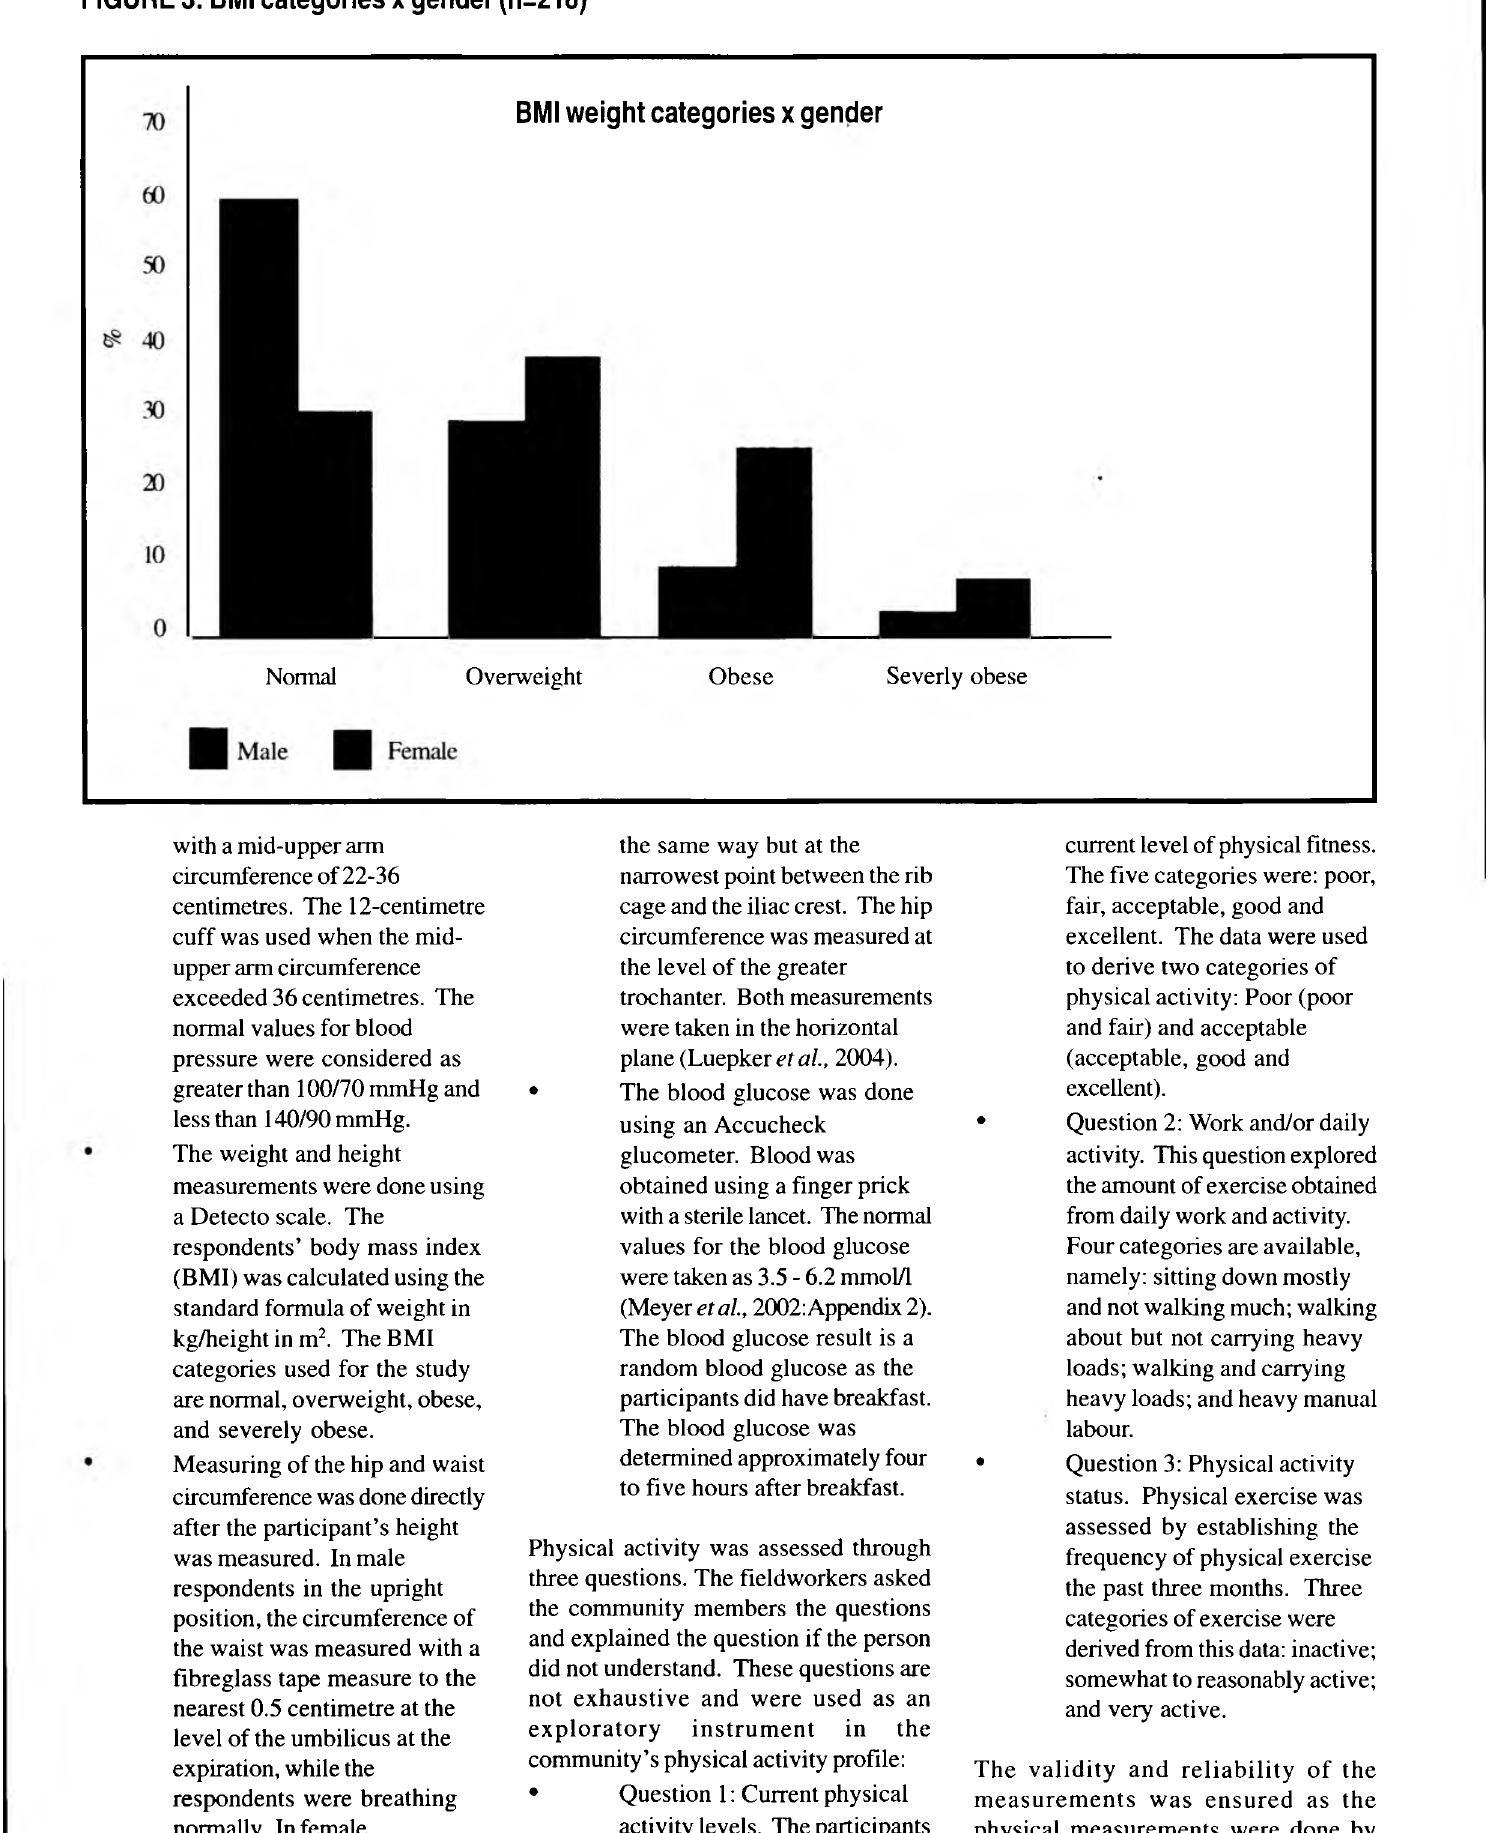
FIGURE 3: BMI categories x gender (n=218) BMI weight categories x